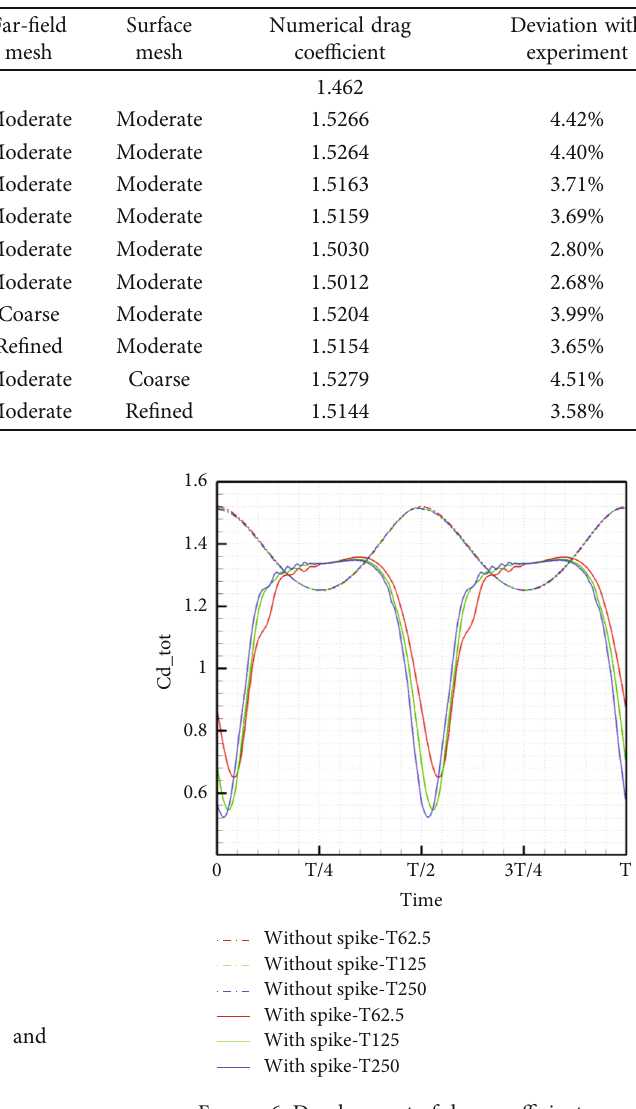
Figure 6: Development of drag coe ffi